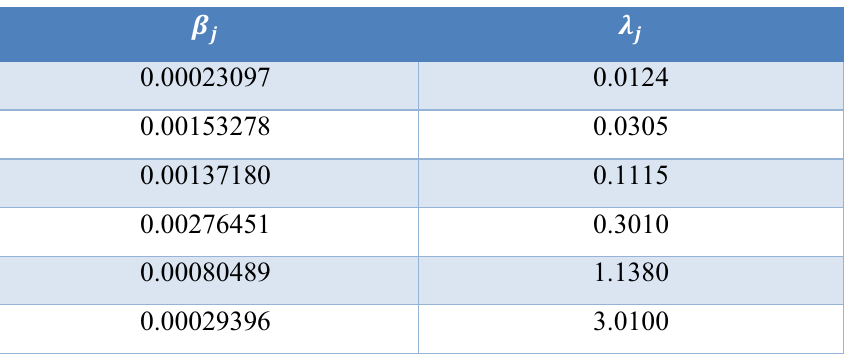
Table 1: Data of the neutron fractions of the precursors of delayed neutrons and data of decay constant of the precursors of delayed neutrons for six group point kinetic equations.